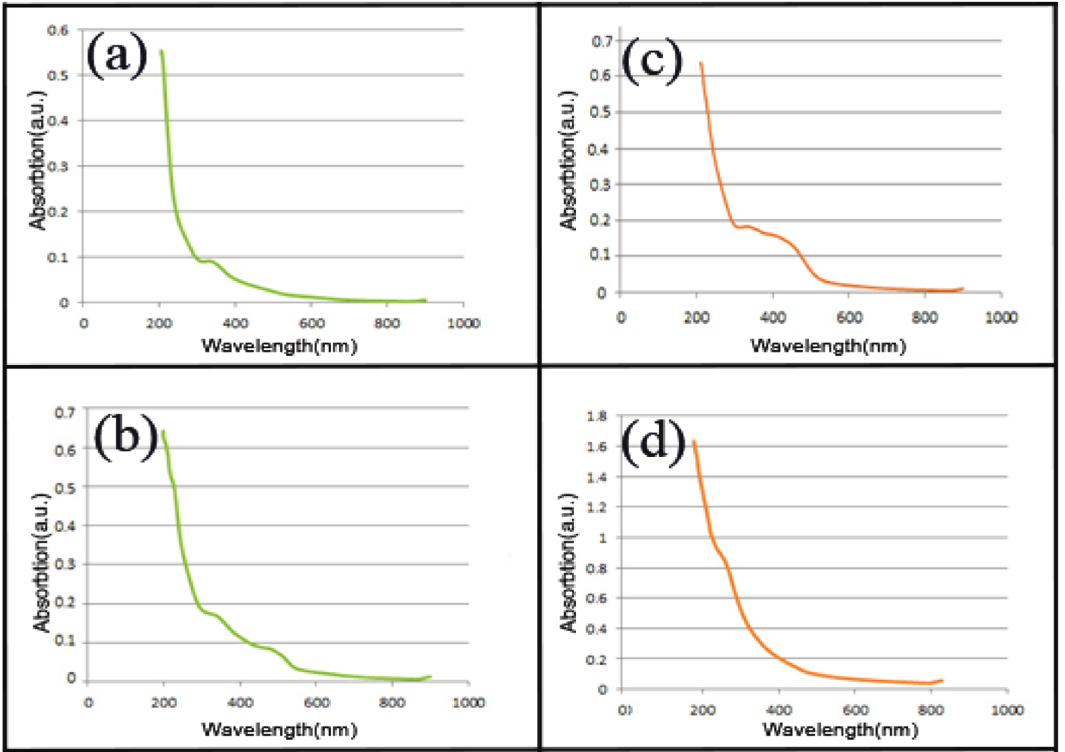
Figure 19: UV-Vis absorption spectra of (a) acid black, (b) acid brown, (c) methyl red, and (d) methyl orange in the presence of